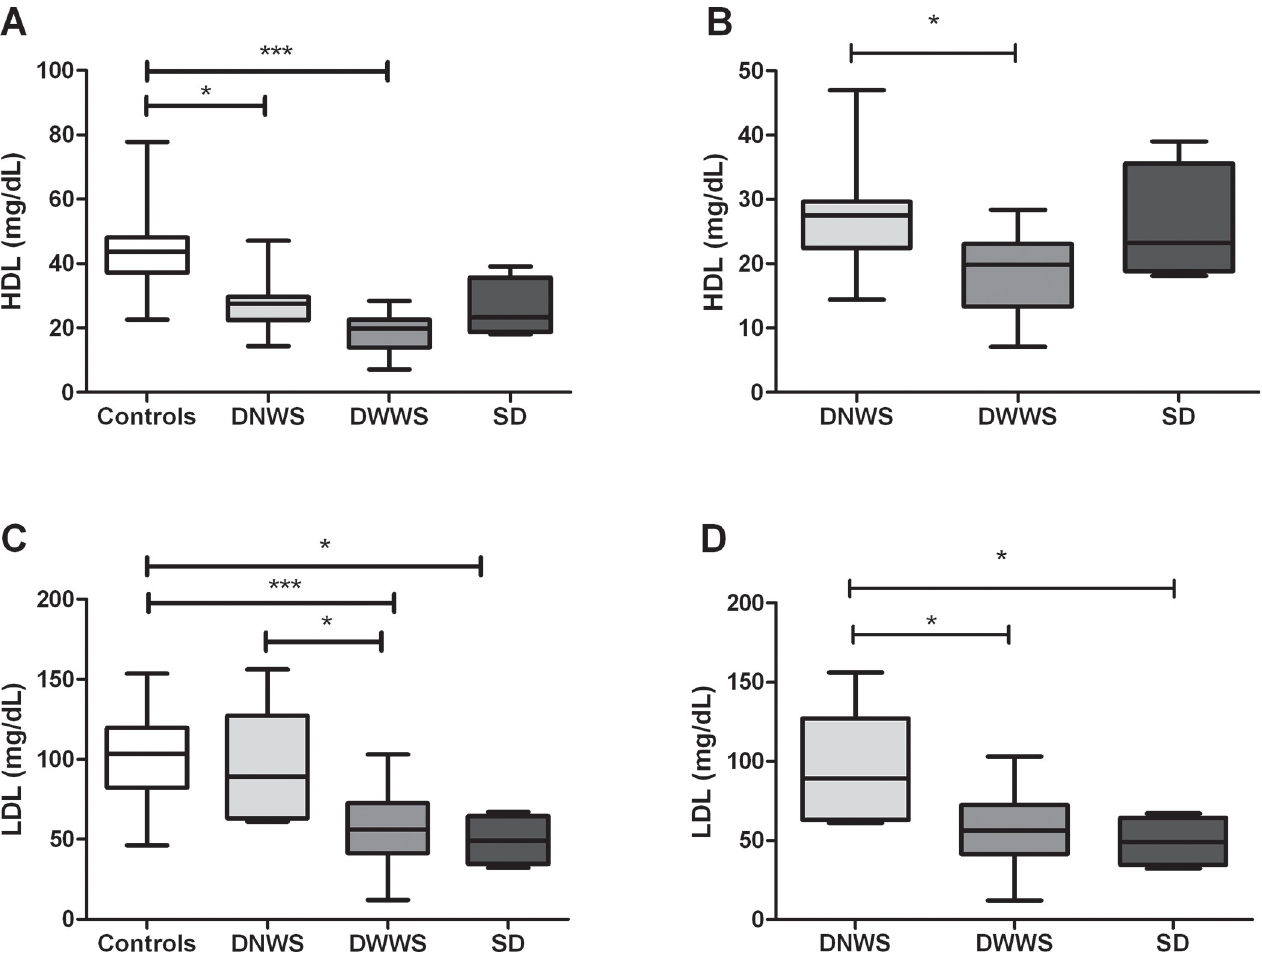
Fig 2. Serum HDL and LDL levels from dengue patients according to clinical classification. HDL (A and B) and LDL (C and D) levels were assessed by duplicated; in the serum of individuals classified has having dengue with no warning signs (DNWS), dengue with warning signs (DWWS) or severe dengue (SD). The results are presented as medians with maximum and minimum values (box and whisker plot). Statistical comparison was made using the Kruskal- Wallis test with a confidence level of 95% and post hoc tests (or multiple benchmarks) HDS of Dunn were applied. Significant differences are represented at the top of the figure ( � p < 0.05; ��� p <